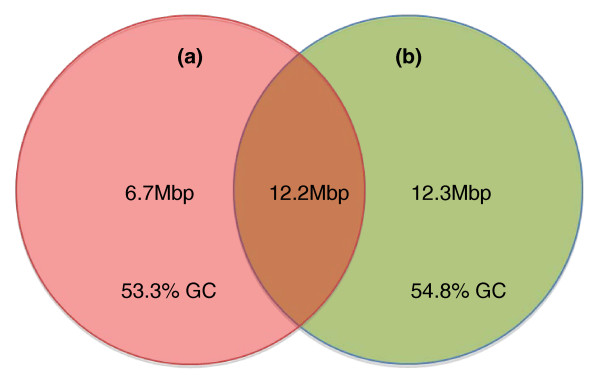
Novel sequence in NGS assemblies compared to the reference assembly. Each assembly was aligned to the Gallus_gallus-2.1 reference using BLAT and unaligned sequence was retained. After contamination removal, the 454/Newbler and Illumina/SOAP assemblies contain 18.9 Mbp and 24.5 Mbp of novel sequence, respectively. The NGS assemblies shared 12.2 Mbp of the non-reference sequence. (a) 454/Newbler (red); (b) Illumina/SOAP (green).